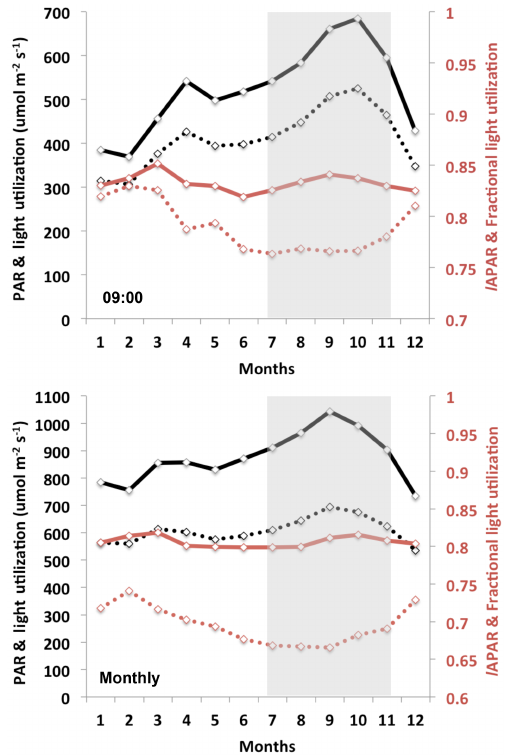
Figure 5. PAR (solid black) and modeled light utilization (dashed black) for DART simulations at 09:00 ( a , top) and monthly av- erage values ( b , bottom), based on a weighted average of hourly DART simulations. Simulated monthly values of l APAR (solid red) and fractional light utilization (dashed red) are plotted on the right-hand axis. Gray shading indicates dry-season months (July–